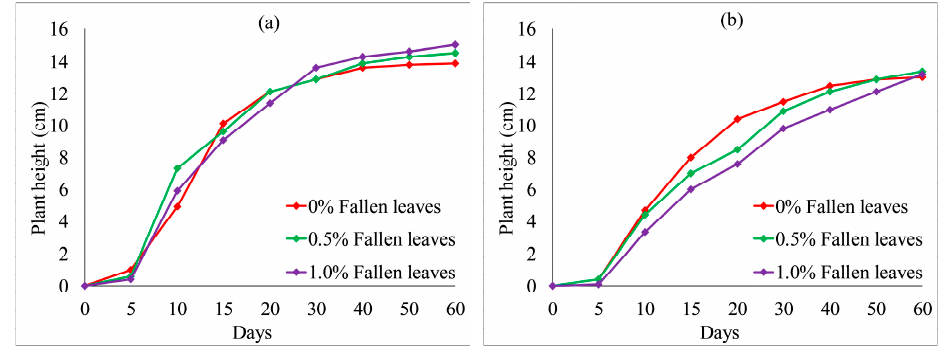
Figure 15. Festuca elata height relative to wheat straw content combined with: ( a ) 5% KW fertilizer content; ( b ) 10% KW fertilizer content.